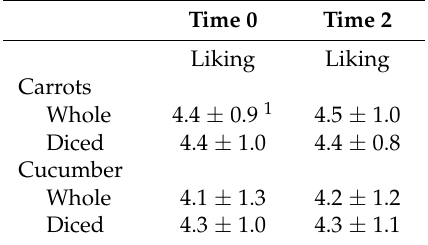
Table 2. Liking of carrots and cucumber (whole and diced) at time zero and time